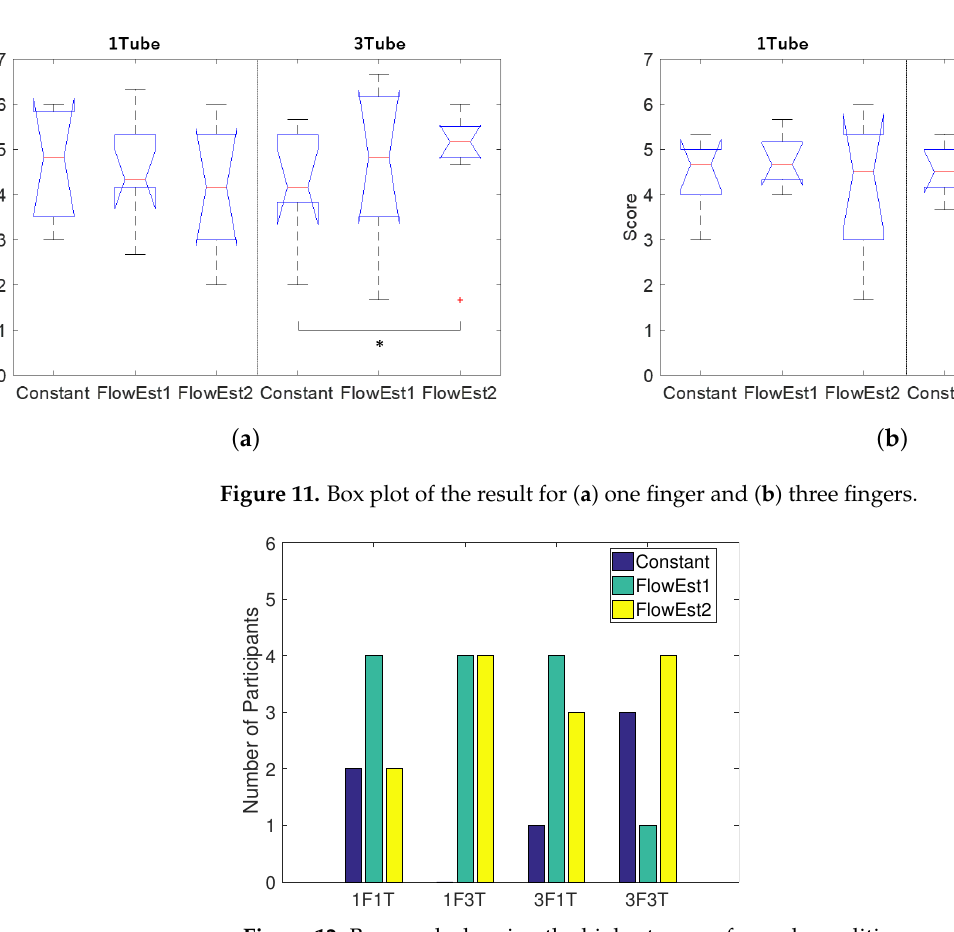
Figure 12. Bar graph showing the highest scores for each